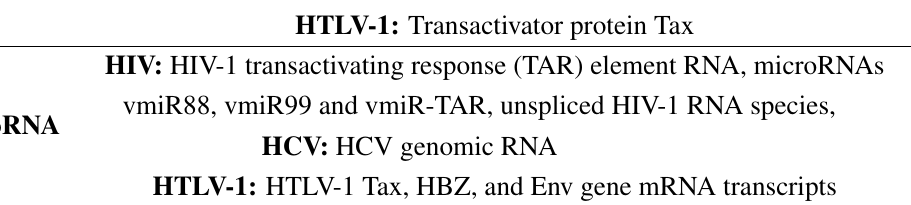
Viral protein and RNA species present in exosomes derived from RNA virus-infected cells. Protein and RNA Species of RNA Viruses Present in Exosomes HIV: Nef and Gag Viral Proteins